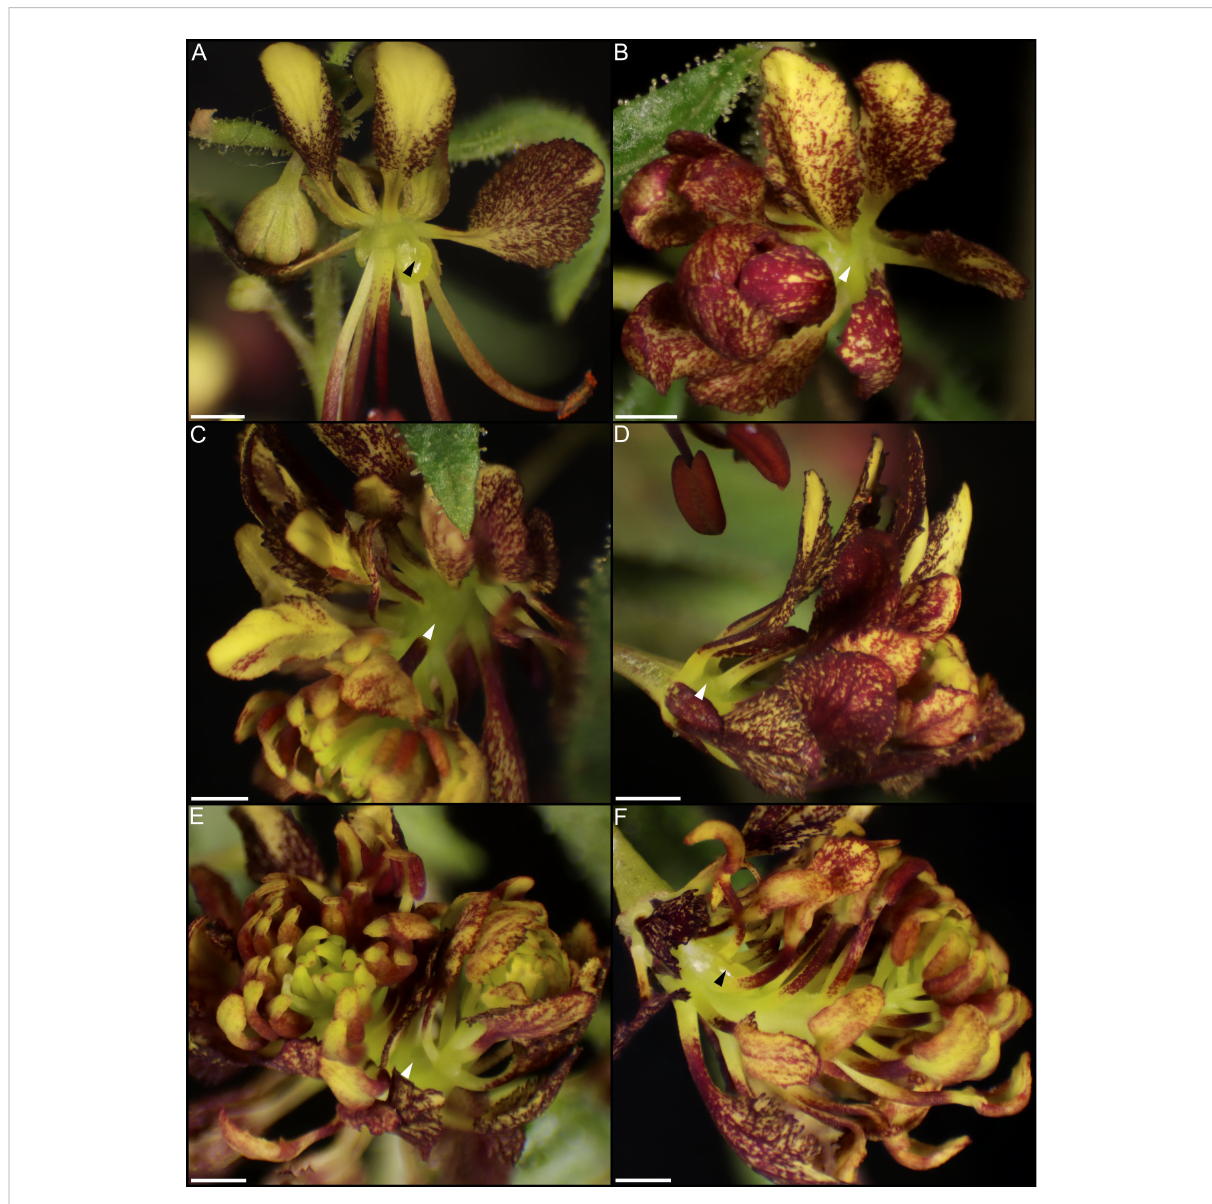
FIGURE 12 Flowers of Cleome violacea treated with pTRV2- CvAG-CvSHP constructs. (A) Flower with partial nectary. (B – E) Flowers with repeating perianth whorls and no nectary. (F) Flower with repeating perianth whorls and partial nectary. Black and white arrowheads represent reduced and absent nectary, respectively. Scale bars = 1